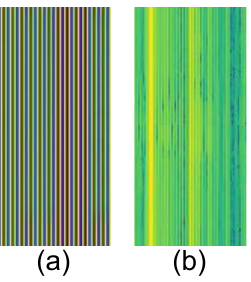
Figure 2. ( a ) A signal image that has been created by an example of the action “reading”; ( b ) the activity image of the signal image of ( a ), upon applying Discrete Sine Transform (DST). Figure best viewed in